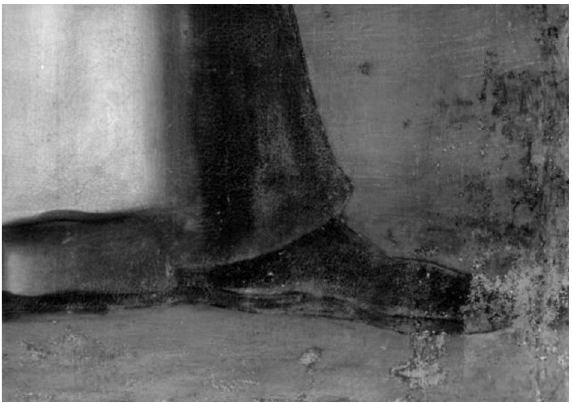
Figure 5. Detail of the IRR image of the left shoe of Saint Dominic of Guzman.